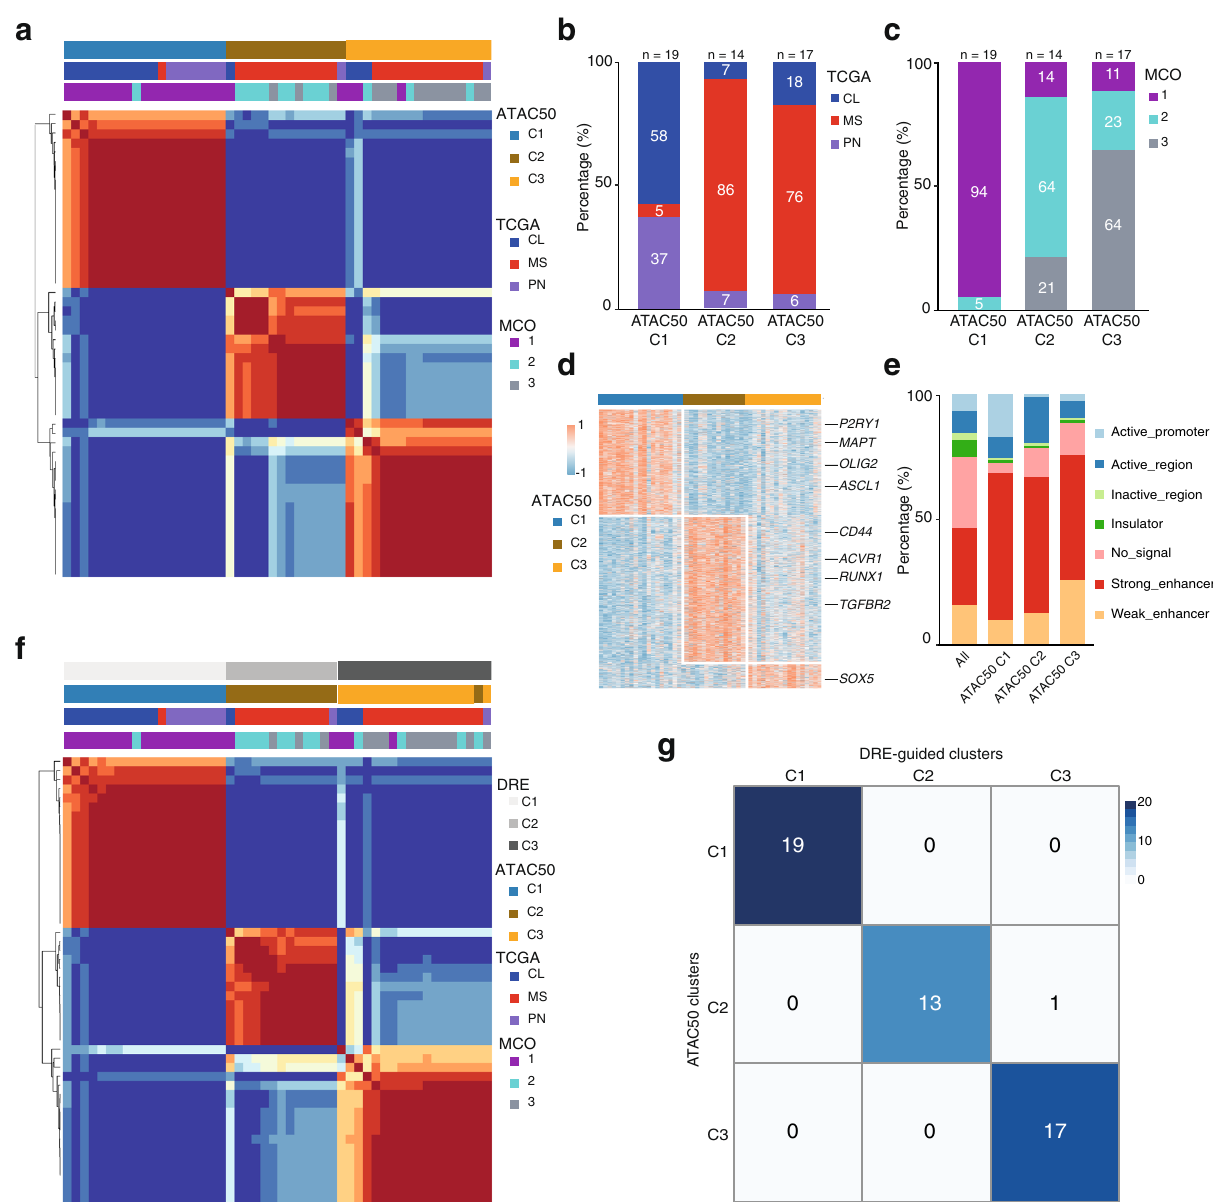
Fig. 3 Chromatin-accessibility robustly identi fi es three clusters of patient-derived GSC cultures. a NMF cluster analysis of ATAC-seq data from 50 patient-derived GSC cultures. b Distribution of TCGA subtypes among ATAC50 clusters. c Distribution of MCO subgroups among ATAC50 clusters. d Heatmap of unique ATAC peaks of each ATAC50 cluster. Examples of genes annotated to the chromatin regions are indicated. e Genomic annotation of all ATAC peaks in the hGSC cohort and unique ATAC peaks of each ATAC50 cluster. f NMF cluster analysis of DRE ATAC peaks from 50 human GSC cultures. g Overlap of ATAC50 clusters with DRE-guided clusters. Source data are provided as a Source Data fi le for Fig. 3a –